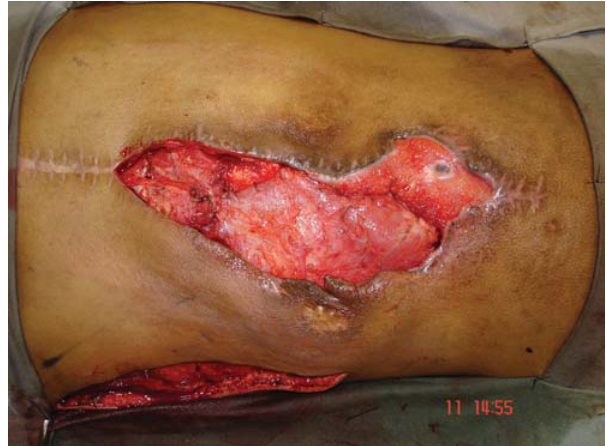
Figure 8 - The left trapezius and latissimus dorsi muscles were used as turnover flaps to cover the defects. Only the distal fifth of the trapezius was employed